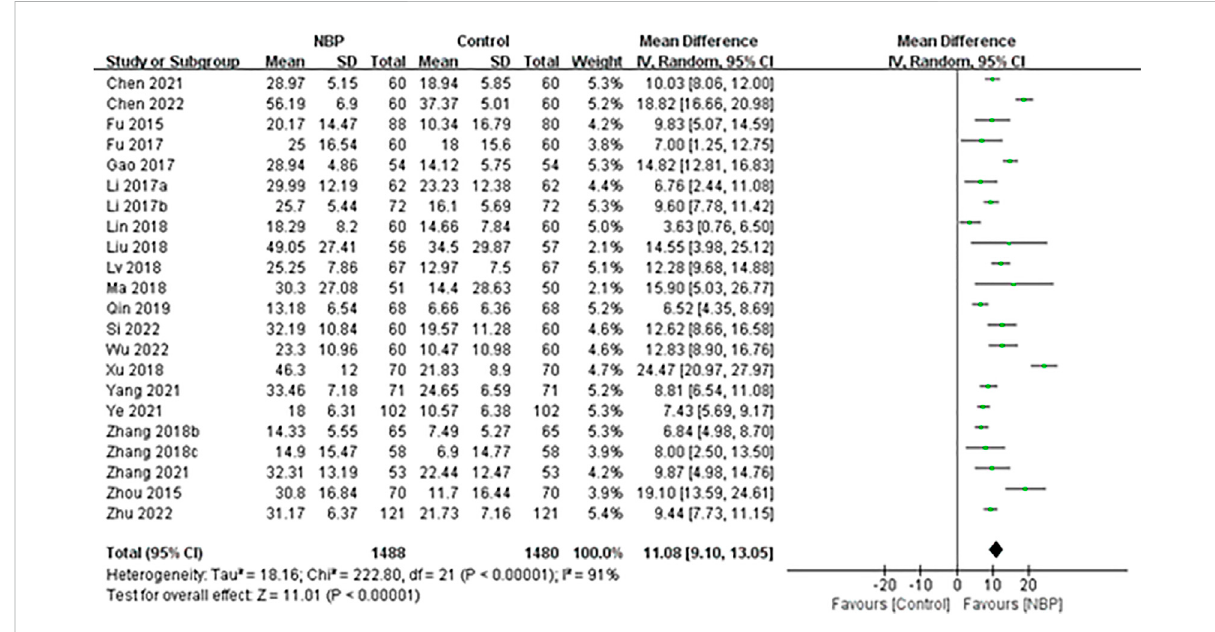
FIGURE 6 Meta-analysis of Barthel Index at the end of treatment or follow-up, as an index of basic activities of daily